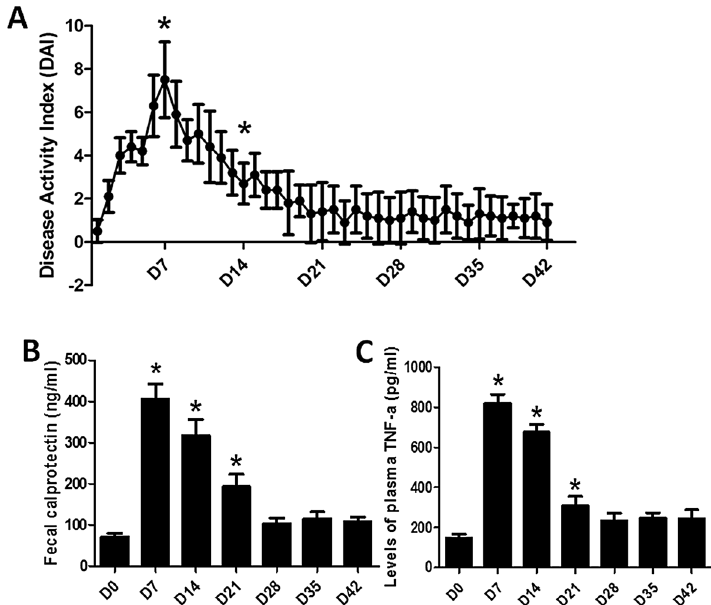
Figure 1. Disease activity index (DAI) ( A ), fecal calprotectin ( B ) and levels of plasma TNF-α ( C ). * P < 0.05 compared with Day 0. ( A : N = 8, B and C : N =